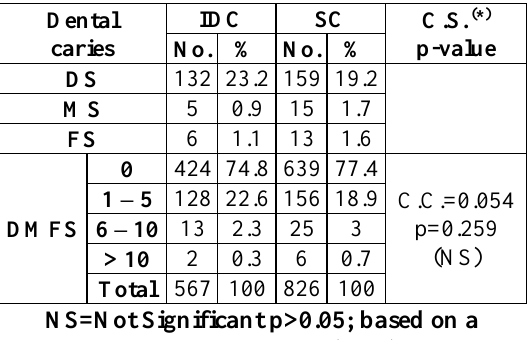
Table 2: Distribution of the children